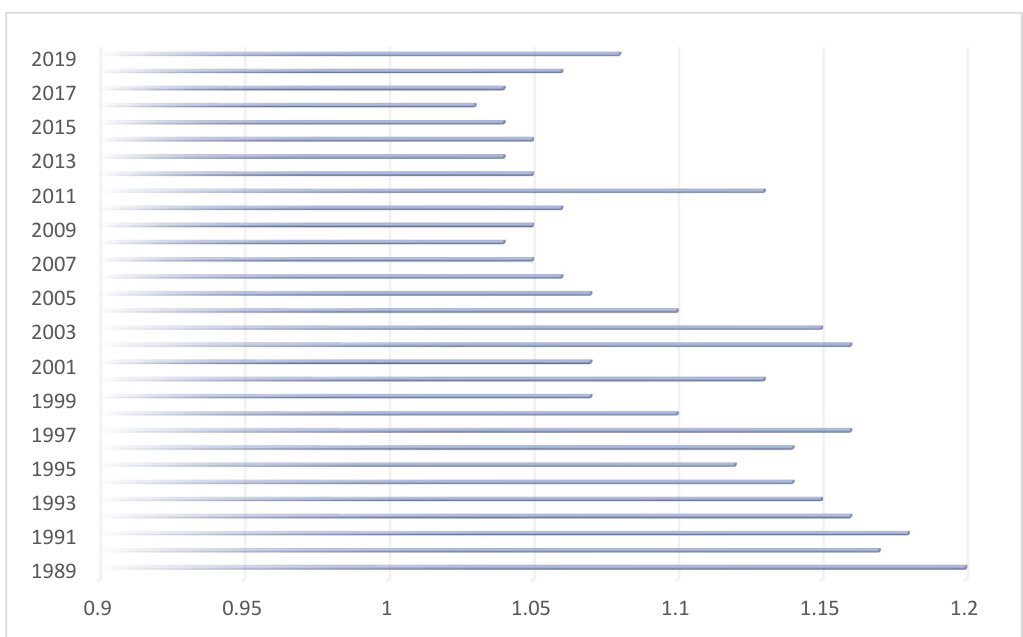
Figure 1. Reduction of CO 2 emissions from 1989 to 2019 [Mg CO 2 /MWh].